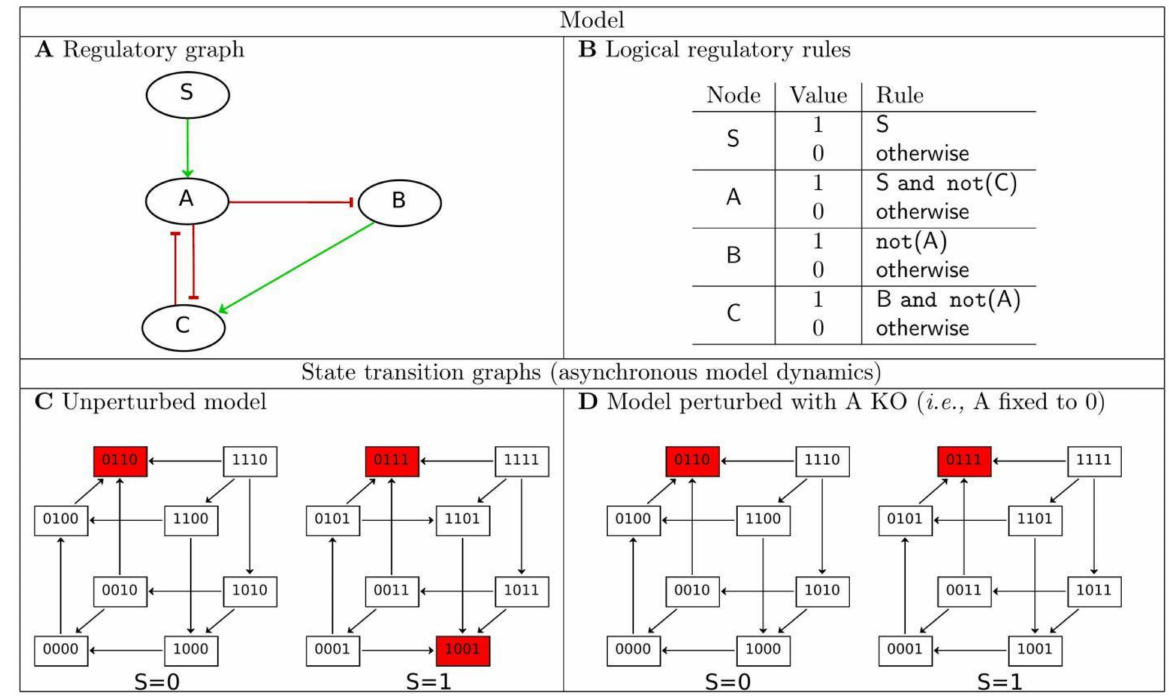
Figure 1. A simple logical (Boolean) model and its dynamics. ( A ) The regulatory graph, where nodes represent model components (three internal and one input nodes), green arrowhead edges denote activations, and red blunt edges denote inhibition; ( B ) Each node value is defined by a logical rule, i.e., the input is maintained constant at its current value, A is activated (A = 1) if S, its activator, is present and C, its inhibitor is absent, otherwise it is de-activated (A = 0), etc.; ( C ) The state transition graph representing the dynamics of the unperturbed model; each node represents a model state with the values of the components [A,B,C,S]; arrowhead edges represent transitions, and trajectories are defined by successions of transitions; when S = 0, there is a single stable state (0110), all trajectories converge to it; when S = 1, there are 2 stable states (0111) and (1001); starting from state (0001), both stable states are reachable, (0111) with probability 0.2514, and (1001) with probability 0.7486; ( D ) The state transition graph when the value of A is blocked to zero, which mirrors a LoF (KO) of A, showing that when S = 1, a stable state is